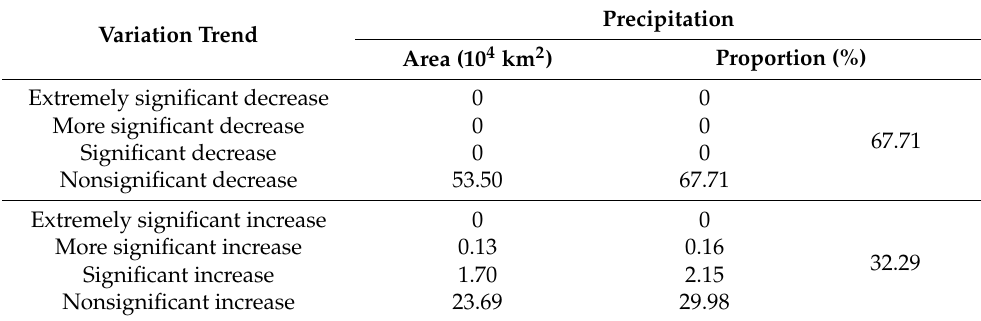
Figure 5. ( a ) Temporal variation, ( b ) spatial distribution of the annual average precipitation and ( c ) the spatial distribution variation trend of annual average precipitation (the abbreviations are the same as for Figure 4) in the humid karst areas during 2002–2018. Table 5. The area and proportion of precipitation variation trend in the humid karst areas during